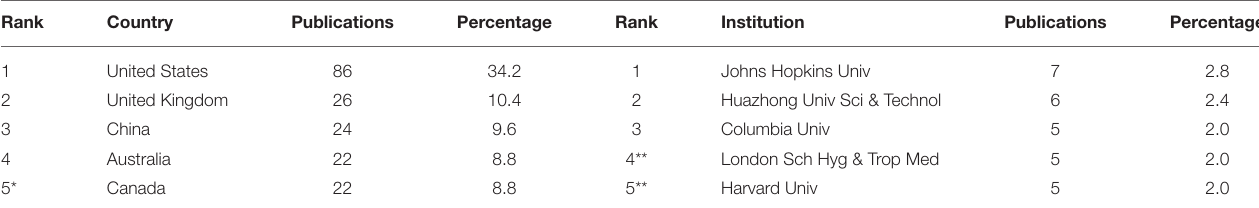
TABLE 1 | Ranking of top five countries and institutions of the research domain. Rank